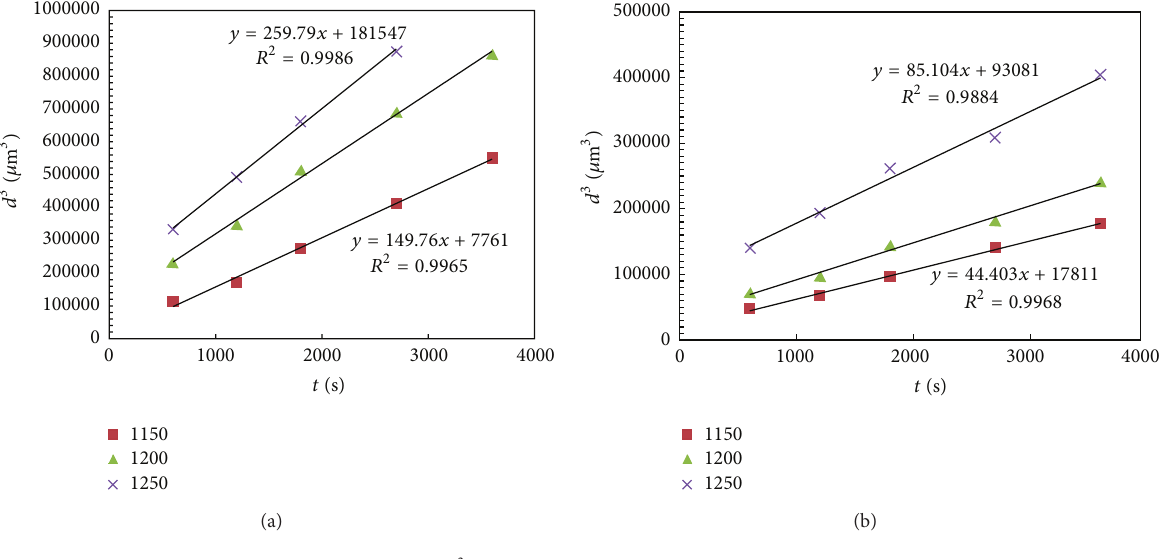
Figure 4: 𝑑 3 versus 𝑡 plot for (a) X65 and (b)